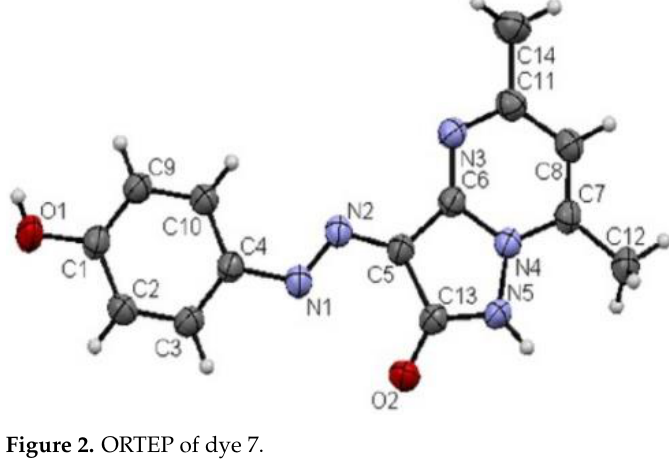
Figure 2. ORTEP of dye 7.